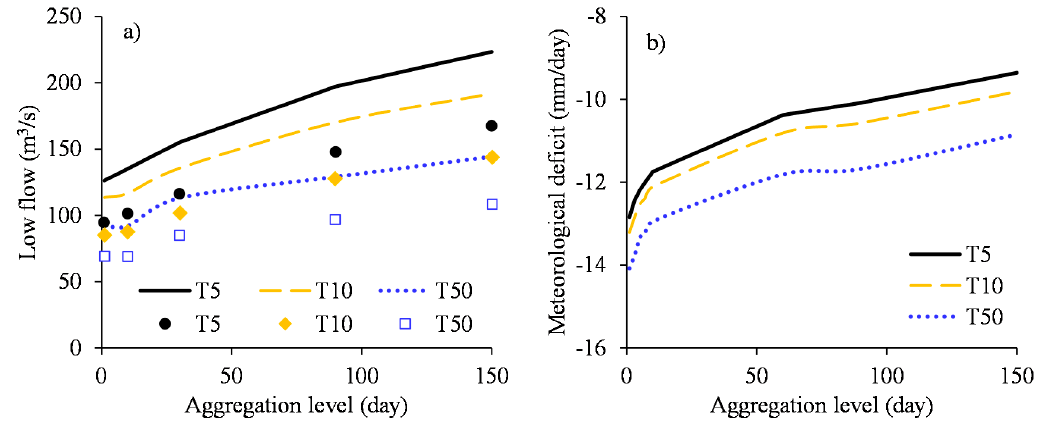
Figure A8. T -year events comprising: ( a ) LFDF relationships; and ( b ) MIDF relationship. For chart ( a ), the T -year events considering stationarity and non-stationarity are presented in the form of lines and markers, respectively. In the legend, e.g., T5 denotes T-year curve for T = 5 years.